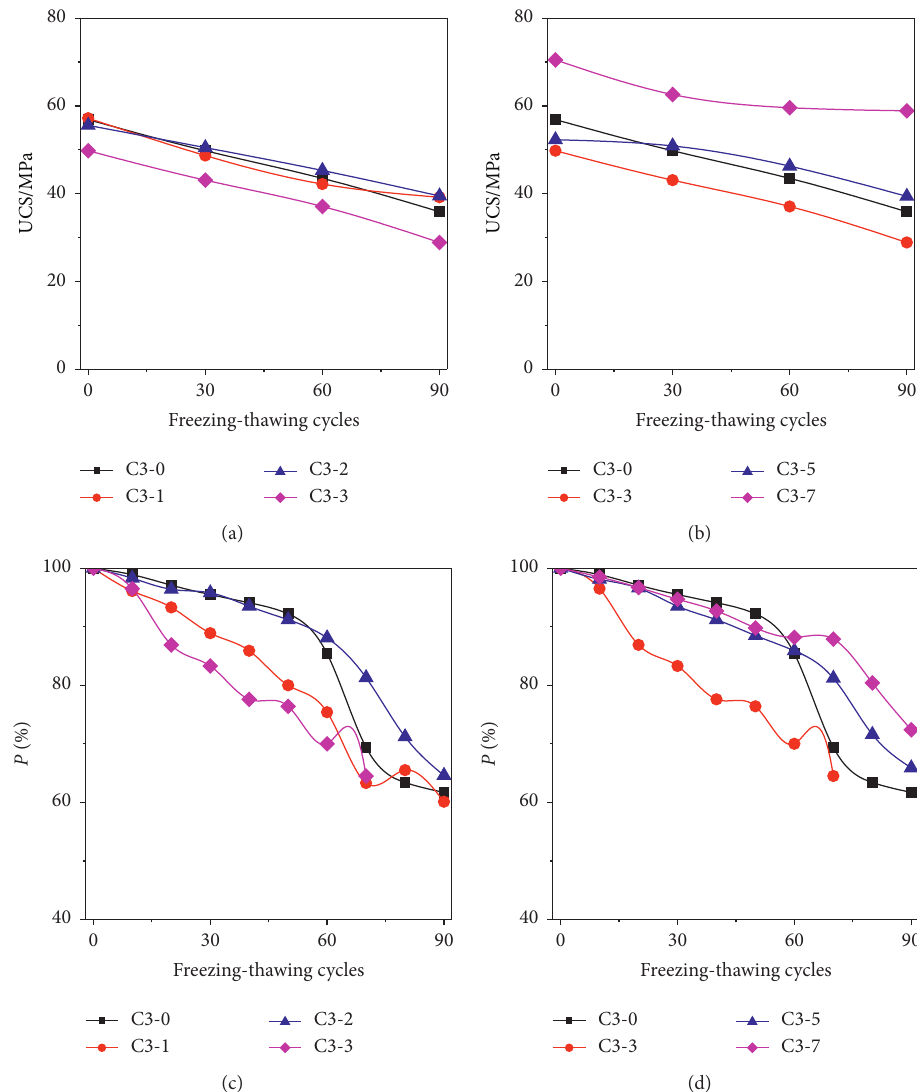
Figure 7: Variation of (a, b) uniaxial compressive strength and (c, d) relative dynamic elastic modulus with the number of freezing-thawing